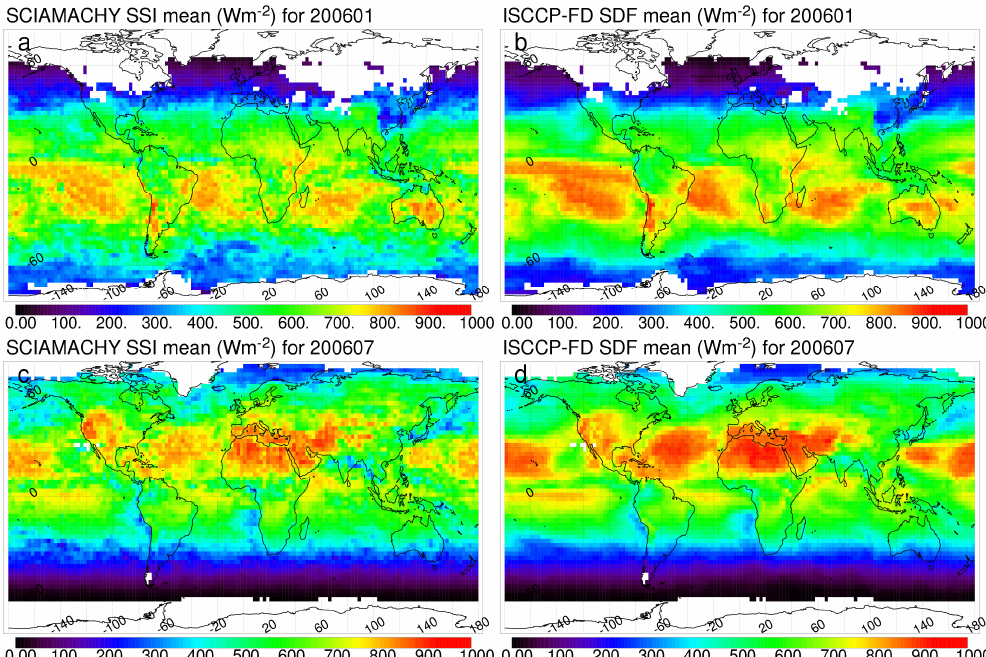
Fig. 10. Maps of the SCIAMACHY surface solar irradiances (SSI) and the ISCCP-FD surface shortwave downwelling fluxes (SDF) for (a, b) January and (c, d) July 2006. The white areas indicate the missing data due to snow/ice at the surface or solar zenith angles larger than 89 ◦